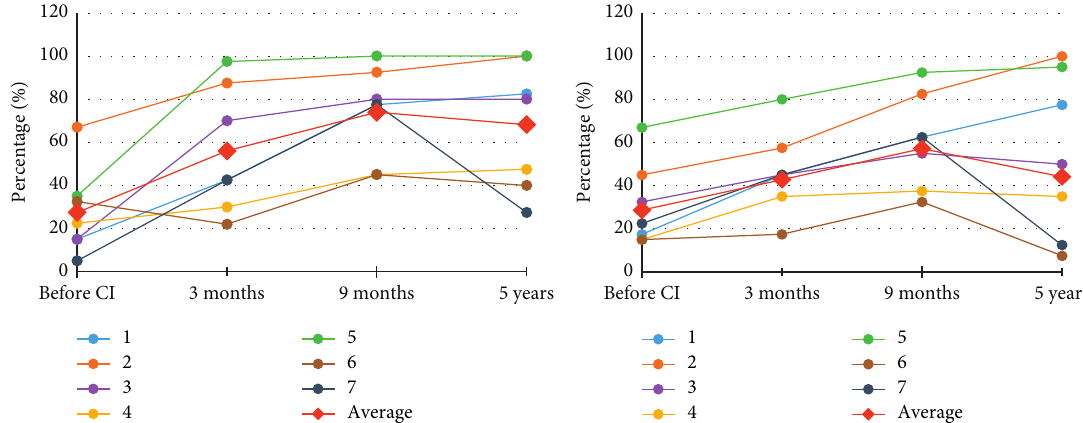
Figure 3: Individual profiles of progression of IT-MAIS/MAIS and MUSS results. Table 2: Comparison of the IT-MAIS/MAIS and MUSS results between the different moments of assessment in the children using CI. Protocol Time of assessment